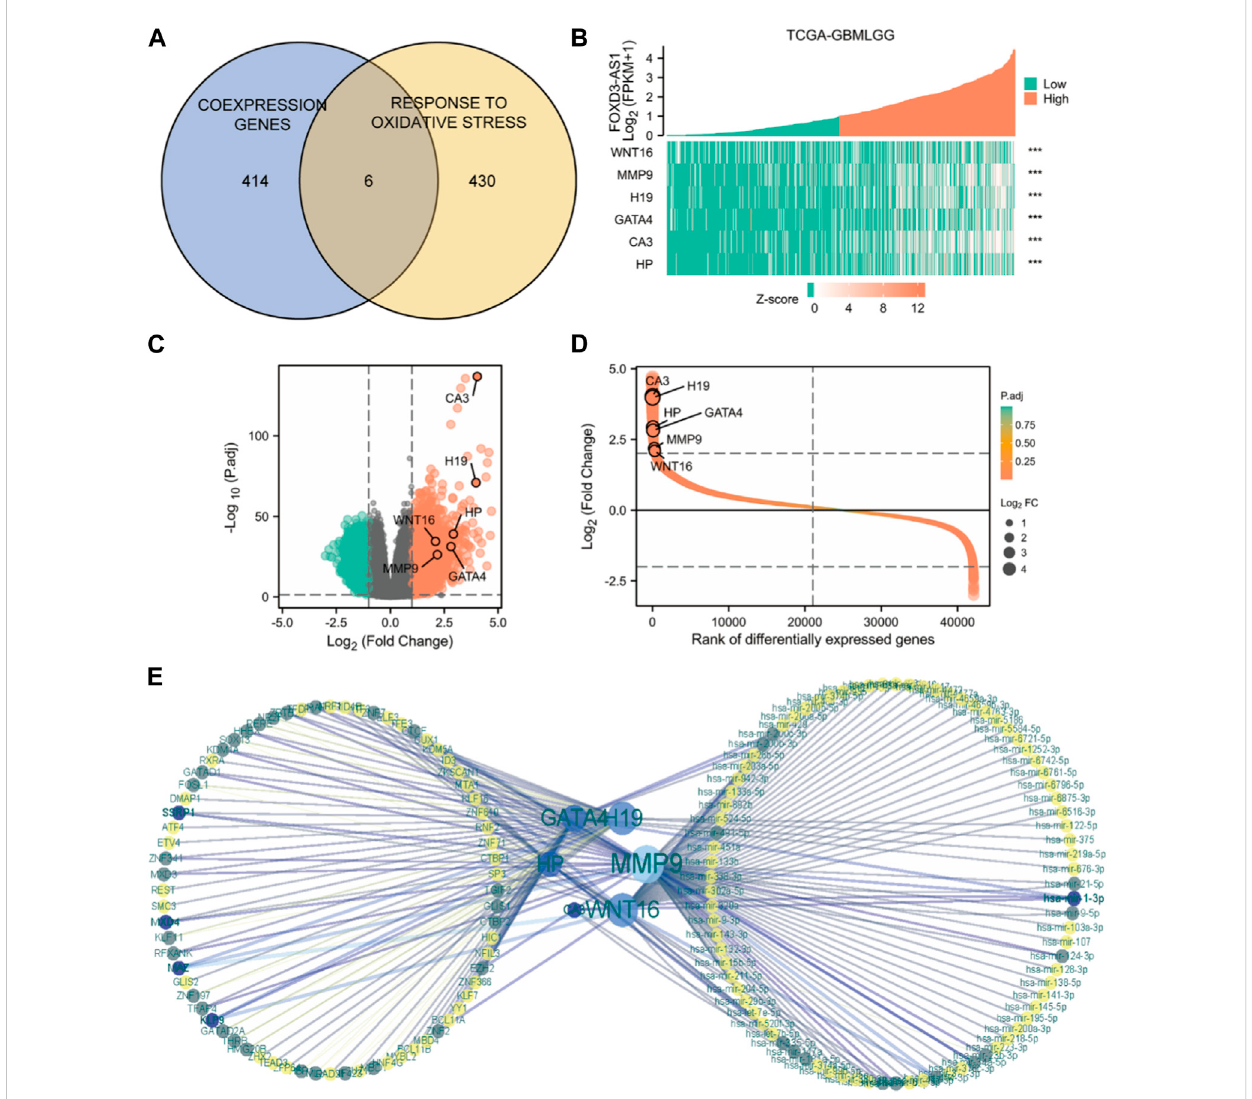
FIGURE 9 Molecular network construction. (A) Venn diagram of intersection of closely related co-expressed genes of FOXD3-AS1 and genes related to the molecular mechanism pathway of oxidative stress; (B – D) shows the differential expression heatmap (B) , Volcano map (C) and molecular differential expression fold ordering map (D) of FOXD3-AS1 ’ s key oxidative stress related co-expressed genes among their expression groups, respectively; (E) miRNA or TF regulatory gene predictive molecular network targeting six oxidative stress co-expressed genes closely related to